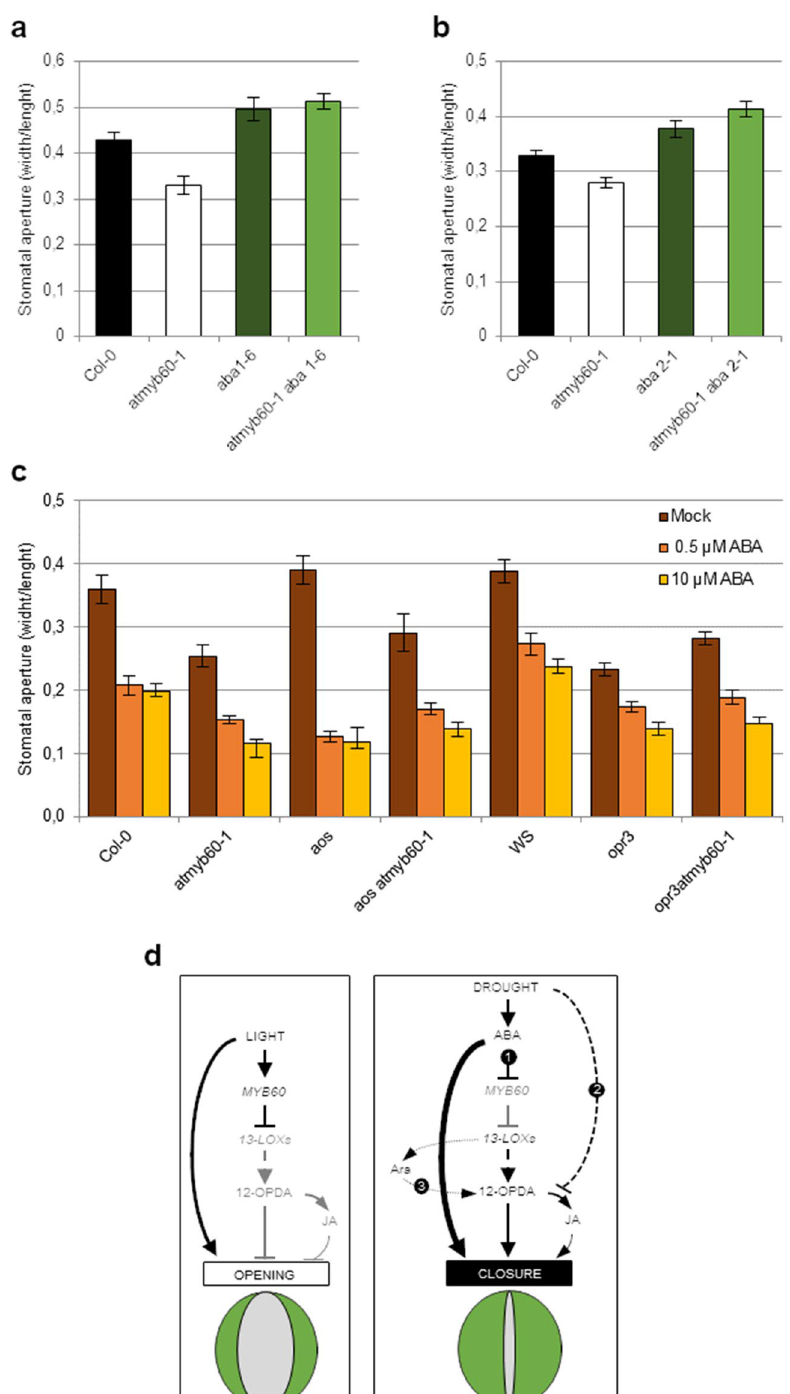
Figure 5. Oxylipin-ABA crosstalk in guard cells. ( a , b ) Stomatal aperture in Col-0, atmyb60-1 , aba1-6 , and aba1-6 atmyb60- 1 leaves ( a ) and in Col-0, atmyb60-1 , aba2-1 , and aba2-1 atmyb60-1 leaves, after 4 h of exposure to light ( b ). ( c ) Stomatal aperture, in Col-0, atmyb60-1 , aos , aos atmyb60-1 , Ws, opr3 and opr3 atmyb60-1 leaves after 4 h of treatment with 0.5 or 10 µM ABA. ( d ) Working model of the AtMYB60 function in guard cells. Under optimal growth conditions (left panel) AtMYB60 restrains oxylipins production, by downregulating the expression of guard cell-related 13-LOXs . Under drought (right panel) ABA plays a predominant role in triggering stomatal closure through the direct activation of ion channels (thick black line). Three interrelated pathways concur to enhance the level of free 12-OPDA in guard cells. (1) ABA indirectly promotes 12-OPDA synthesis by suppressing AtMYB60 expression and releasing its negative effect on 13-LOXs activity. (2) Drought uncouples the conversion of 12-OPDA to JA, favoring the accumulation of 12-OPDA over JA. (3) The release of 12-OPDA from Arabidopsides contributes to enhance the pool of free 12-OPDA. Accumulation of 12-OPDA promotes stomatal closure independently of JA and cooperatively with